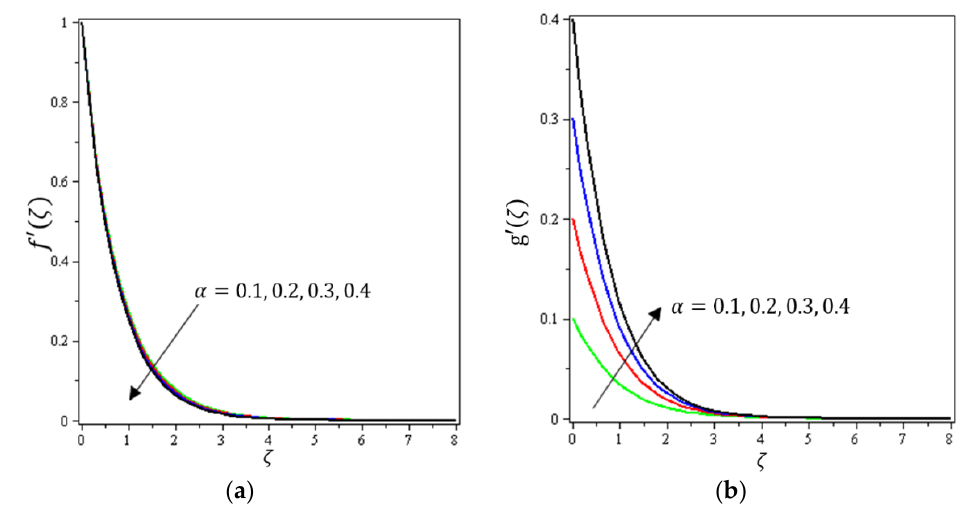
Figure 4. Influence of permeability parameter 𝜆 on velocities ( a ) 𝑓′(𝜁) and ( b ) g ′(𝜁) .